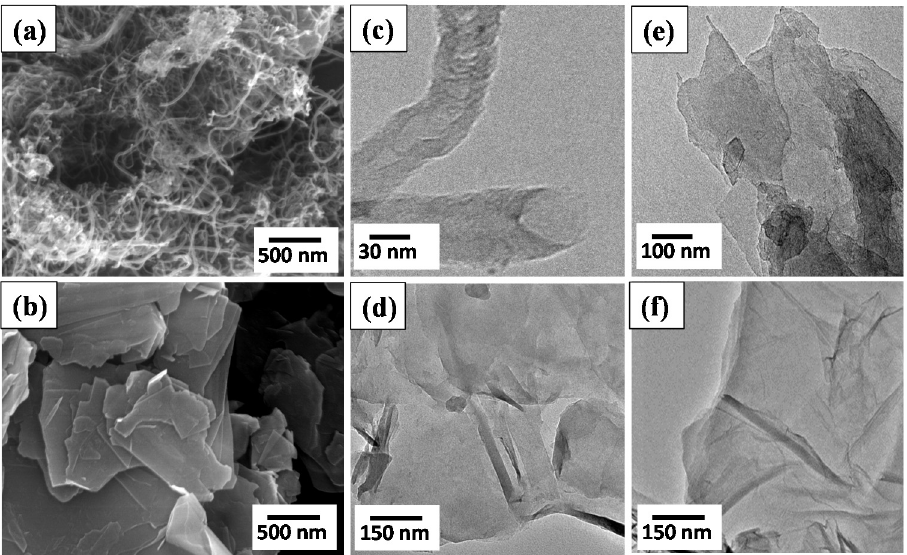
Figure 1. Field ‐ emission SEM (FE ‐ SEM) images of ( a ) carbon nanotubes (CNTs) and ( b ) graphite Figure 1. Field-emission SEM (FE-SEM) images of ( a ) carbon nanotubes (CNTs) and ( b ) graphite powders. High ‐ resolution transmission electron microscopy (HR ‐ TEM) micrographs of ( c ) Graphene powders. High-resolution transmission electron microscopy (HR-TEM) micrographs of ( c )